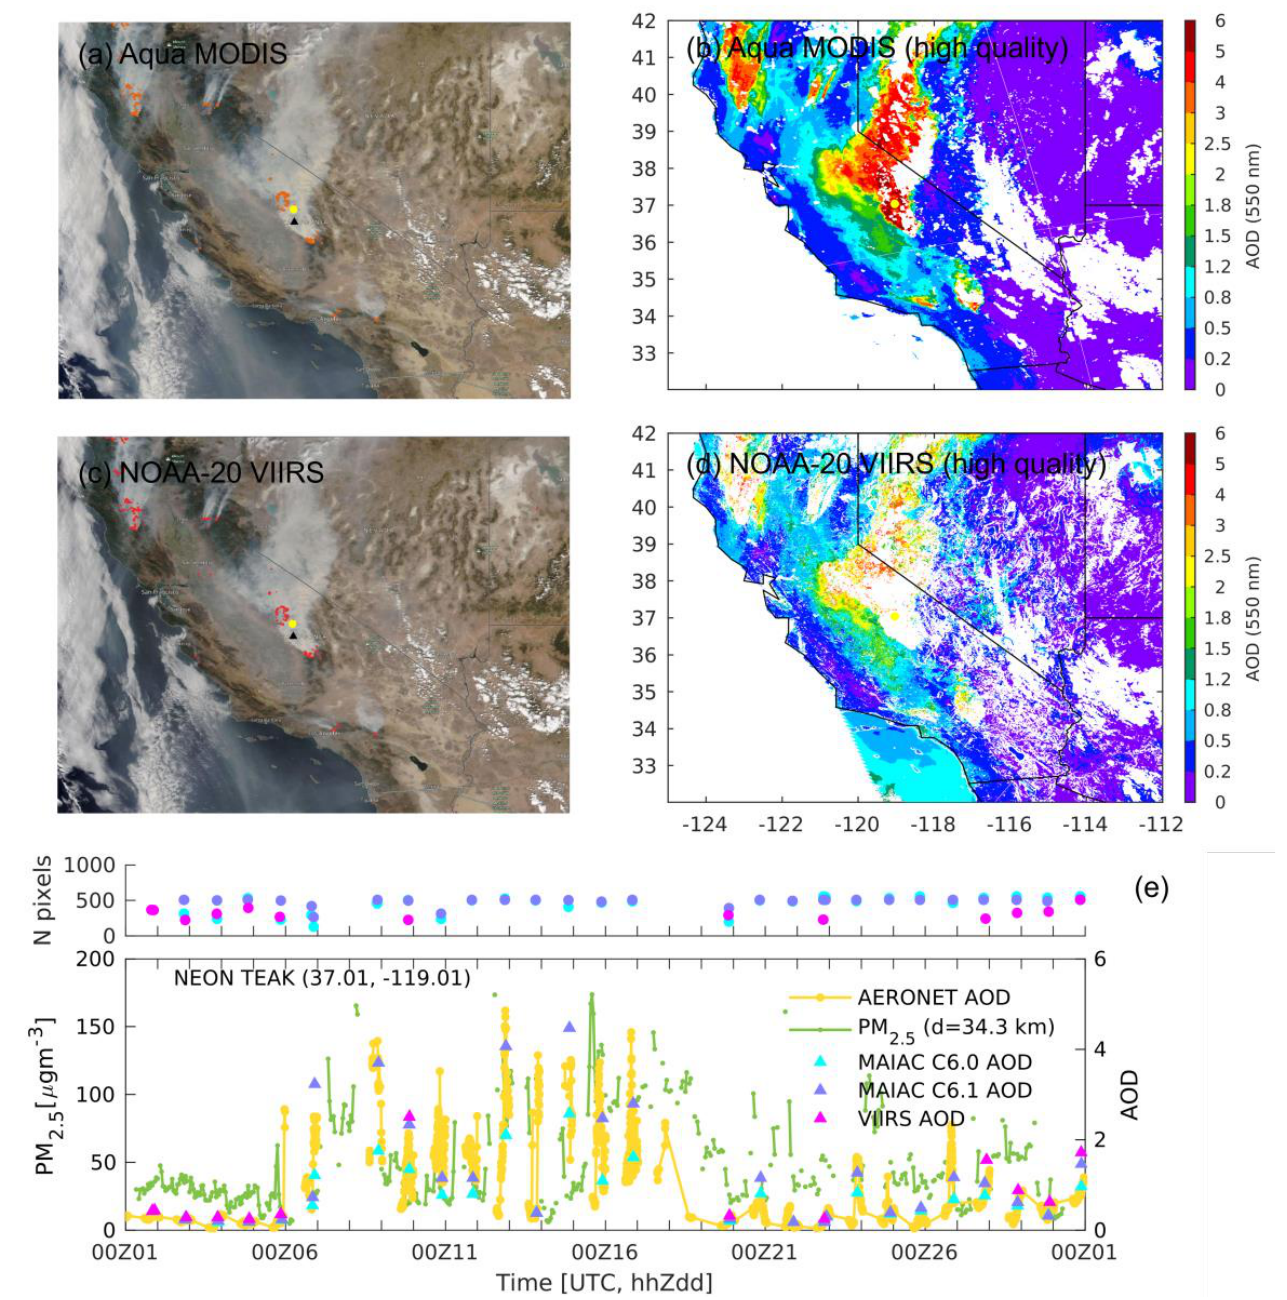
Figure 6. Snapshots of ( a ) Aqua MODIS and ( c ) NOAA-20 VIIRS true color images on 14 September 2020, obtained from the NASA Worldview (https://worldview.earthdata.nasa.gov/, accessed on 8 April 2022). The orange and red dots stand for fire hotspots detected by the two sensors. Panels ( b , d ) show map distributions of AOD (550 nm) from Aqua MODIS MAIAC C6.1 and VIIRS on the same day. The data (high-quality) are shown at their native resolution. ( e ) Time series of AOD (right axis) at the AERONET site NEON TEAK (yellow dot) and collocated satellite AODs at this site from the three products in September 2020. The dots (in same color coding as the AOD plot) stand for number of satellite pixels filtered to derive the matchups with AERONET. The green line shows surface PM 2.5 concentration (left axis) measured at the closest EPA monitor (black triangle). The time format on x-axis is hhZdd (hour and day of month). Distance between the EPA monitor and NEON TEAK is noted in parenthesis (d = 34.3